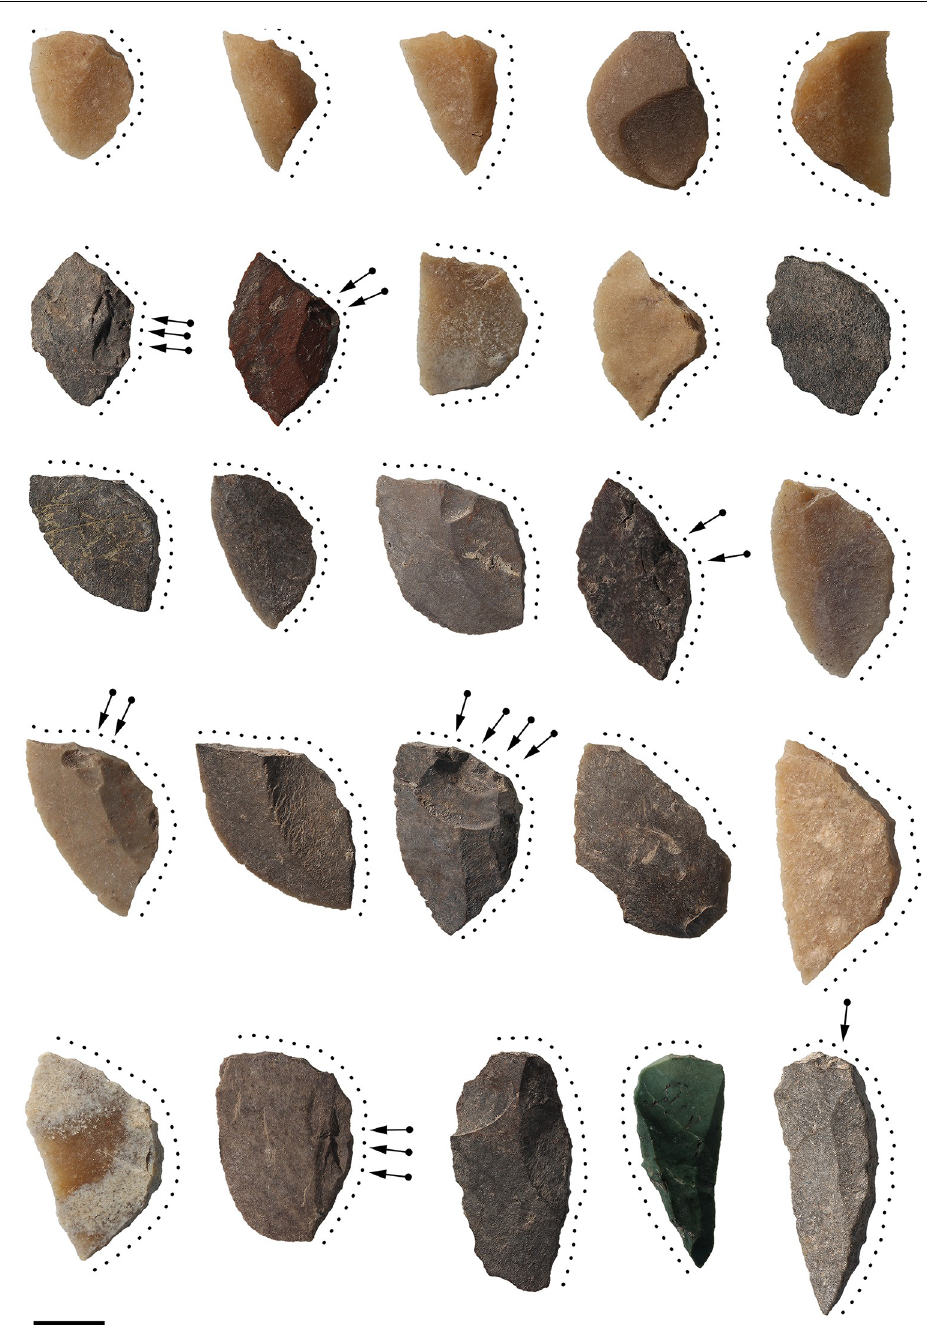
Fig 7. Leang Panninge backed microliths. The microliths are oriented with the percussion axis vertical, the dorsal surface facing up, and the flake blank’s proximal end towards the top of the page. The extent of backing is indicated by dotted lines, and diacritical marks denote the retouching across the visible face of the microliths. Scale bar = 1 cm. Image credit: Nur Ihsan.